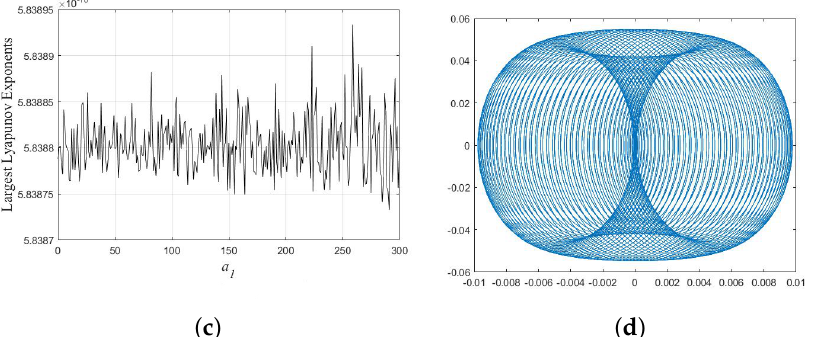
Figure 4. System (7): ( a ) Largest Lyapunov Exponents for a 3 ; ( b ) Largest Lyapunov Exponents for a 1 ; ( c ) Largest Lyapunov Exponents for a 2 ; ( d ) Phase portrait, when a 1 = − 0.80357, a 2 = − 0.4, a 3 = − 1.7149, R 1 ( ξ ) = cos ( 10 ξ ) .